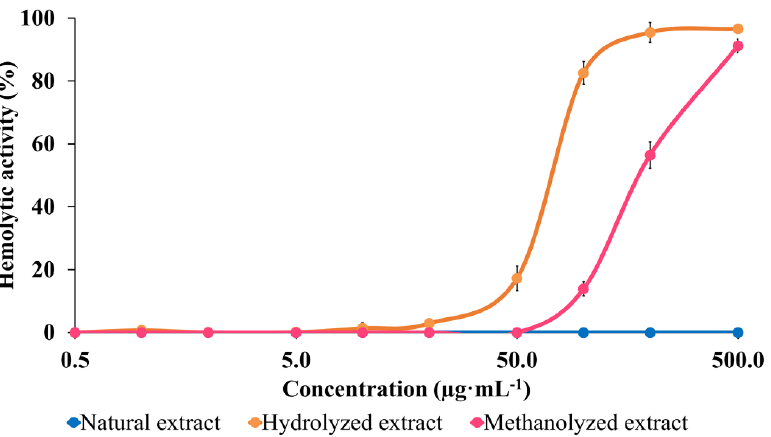
Figure 7. Cytotoxicity evaluation of the three saponin extracts: hemolytic activity comparison between the natural bidesmosidic saponins, the hydrolyzed saponins, and the transesterified saponins. Experiments were performed in triplicate, using a 2% erythrocytes suspension from bovine blood. Hemolytic activities are expressed in % of the activity of the referent, a 500 µg·mL − 1 solution of A. hippocastanum saponins.